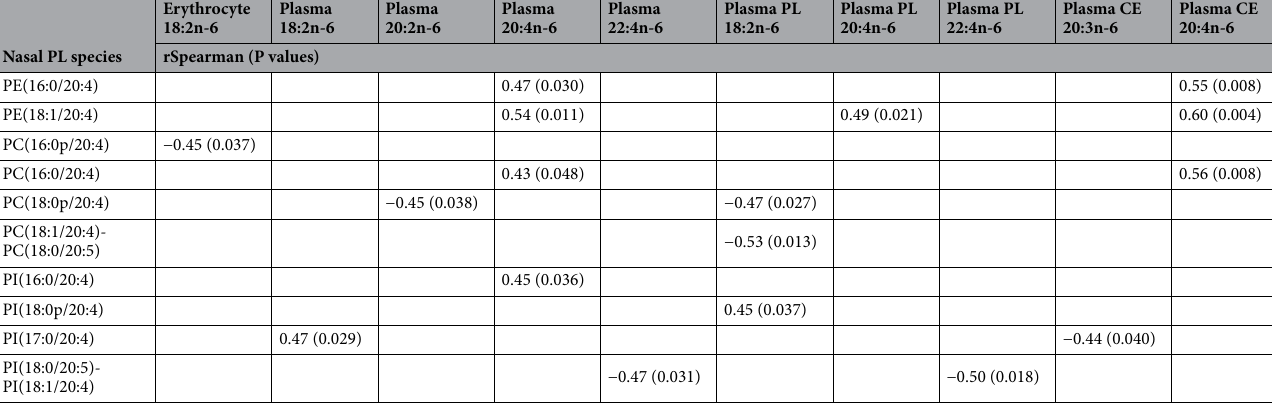
Table 5. Significant associations between nasal arachidonic acid (20:4)-containing phospholipid species and blood n-6 polyunsaturated fatty acids (Spearman test; n = 23). CE cholesterol ester, PC phosphatidylcholine,